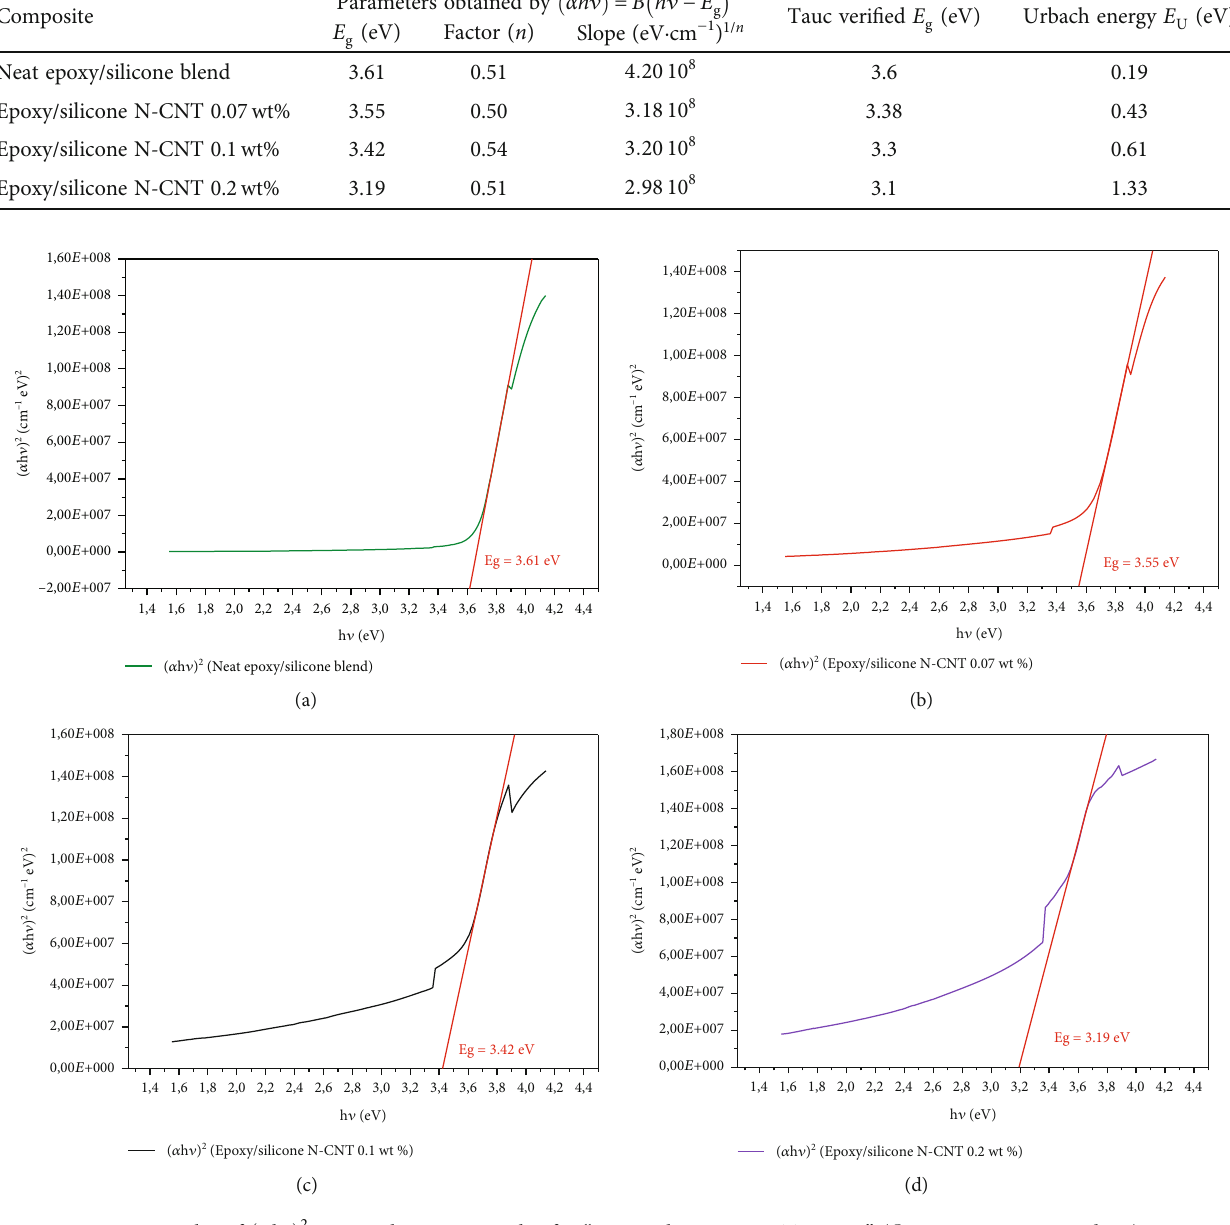
, power factor ( n ), Tauc veri fi ed E g Parameters obtained by α h ν ð Þ = B h ν − E